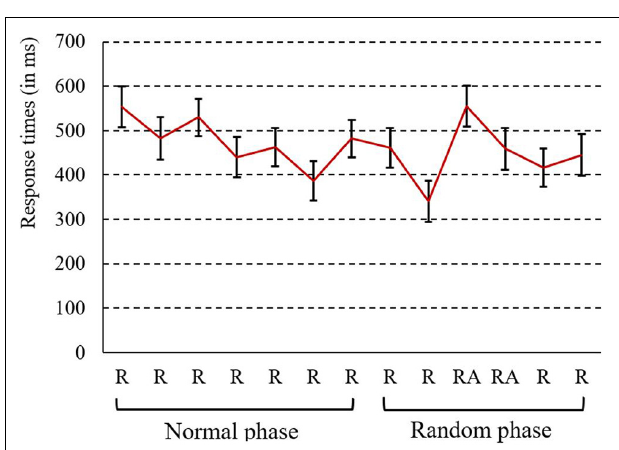
FIGURE 7 | Response time results for the second part of Experiment 2a (R = regular block; RA = random block). Error bars show standard